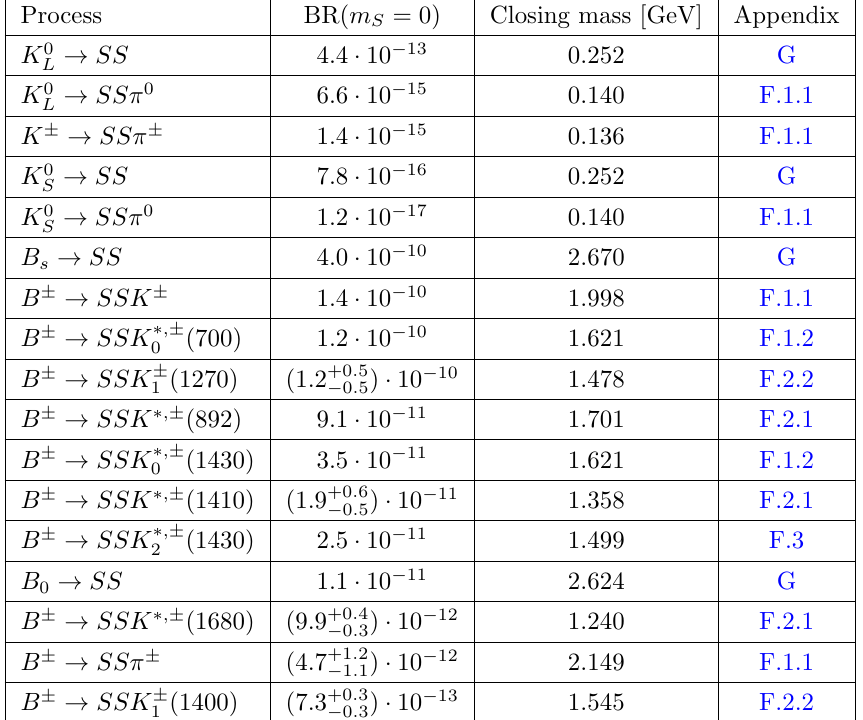
Table 4 . Properties of the main production channels of a scalar S from kaons and B mesons through quartic coupling (2.14). First column : decay channels; Second column : branching ratios of 2-body meson decays evaluated at m S = 0 and (cid:11) = 1 GeV, see eqs. (G.7), (G.8). For B mesons the numerical values are given for B (cid:6) mesons; in the case of decays of B 0 mesons, all the given branching ratios should be multiplied by a factor 0 : 93 that comes from the di(cid:11)erence in total decay widths of B (cid:6) and B 0 mesons [44]. Uncertainties (where available) follow from uncertainties in meson transition form-factors; Third column : e(cid:11)ective closing mass, i.e. a mass of a scalar at